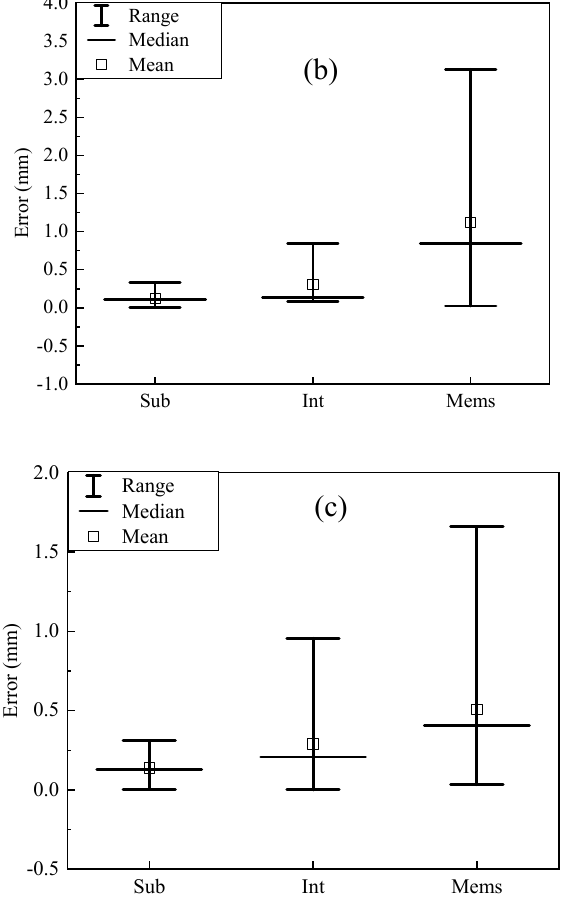
Figure 9. Error analysis of experiments: ( a ) 4 mm at 2 Hz; ( b ) 2 mm at 2.5 Hz; ( c ) 1.5 mm at 3 Hz (Sub—subpixel method, Int—integer pixel method, Mems—MEMS accelerometer method).